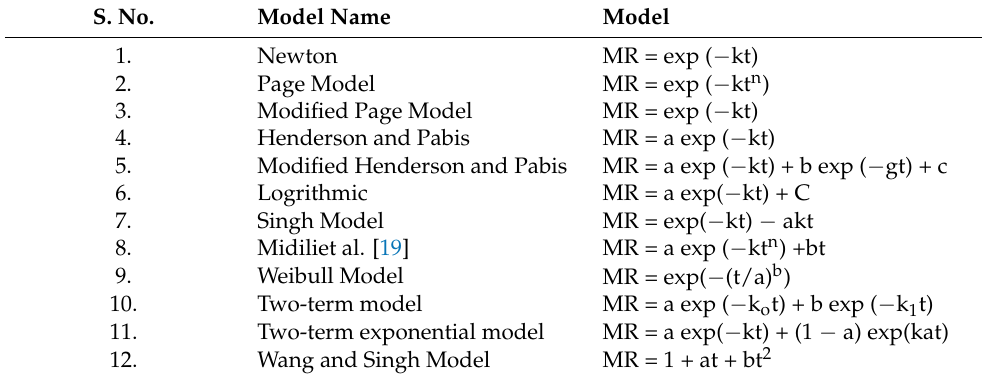
Table 1. Drying models applied to wheatgrass samples’ drying curves. Source: Hawa et al. [22]. S.